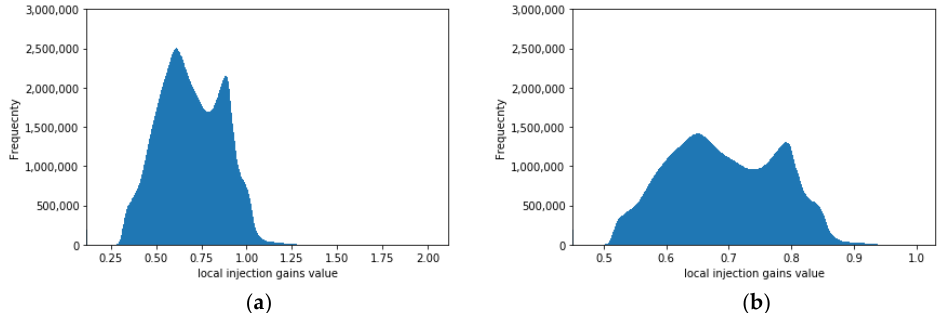
Remote Sens. 2019 , 11 , x FOR PEER REVIEW 16 of 20 to that of the original panchromatic image compared with those of the pansharpened images generated by the GSA and MTF-GLP. Additionally, the LSF curves of the pansharpened images obtained by the GSA and MTF-GLP have a relatively wide full width at half maximum (FWHM), and